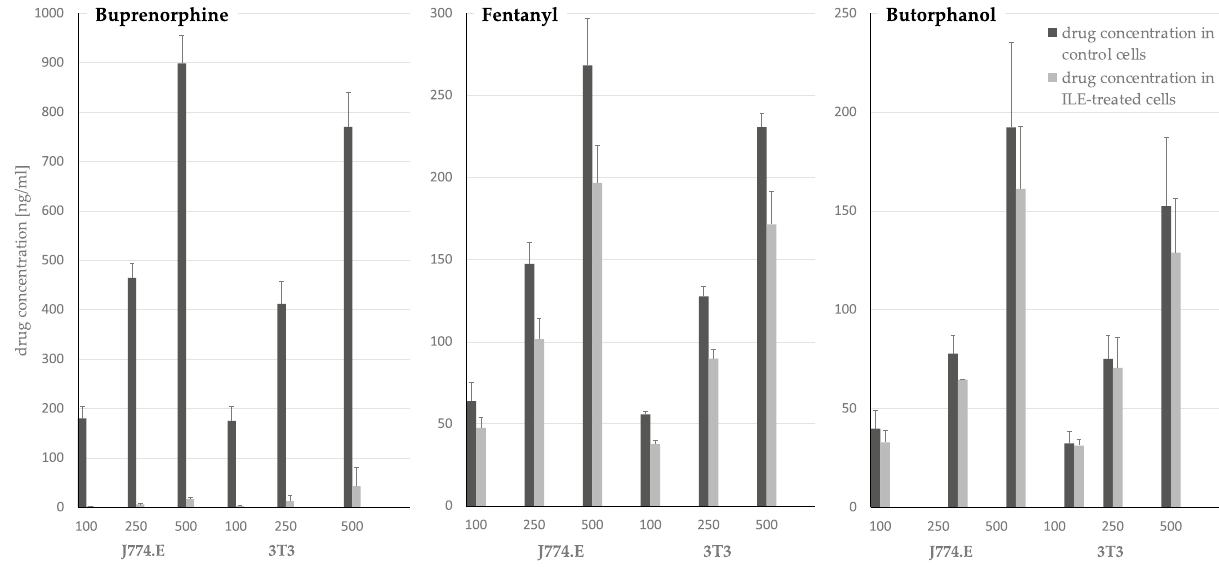
Figure 1. Concentrations of different drugs in cells incubated with or without Intralipid. Each drug was tested at three different concentrations in two cell lines, as denoted on the horizontal axes. Black columns show concentrations in cell monolayer incubated with the drugs and without Intralipid, and light grey columns show the concentrations after incubation with Intralipid. Vertical bars represent standard